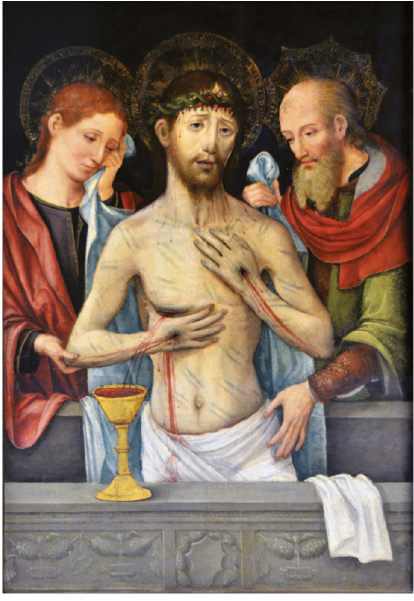
Figure 4. Man of Sorrows, Vicente Macip, first half of the 16th century, Museu de Belles Arts of Valencia. © Museu de Belles Arts of Valencia